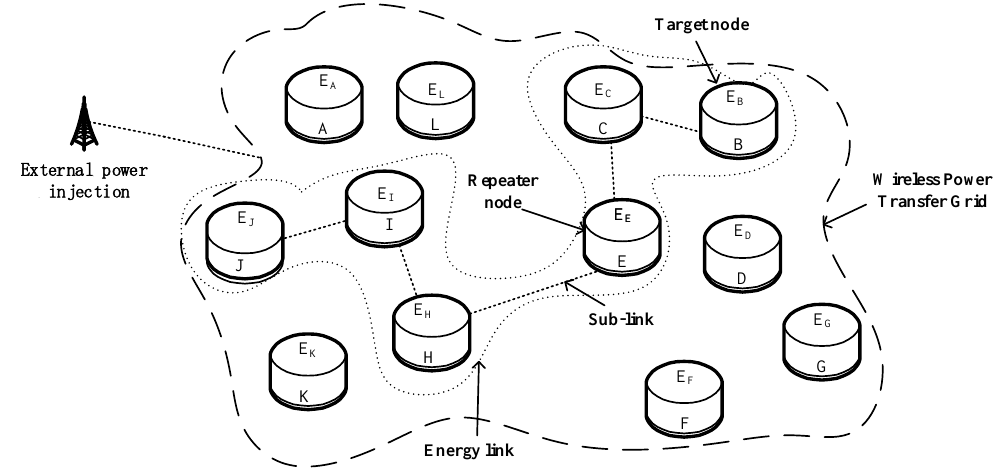
Figure 1. Architecture of a wireless power transfer grid with external power